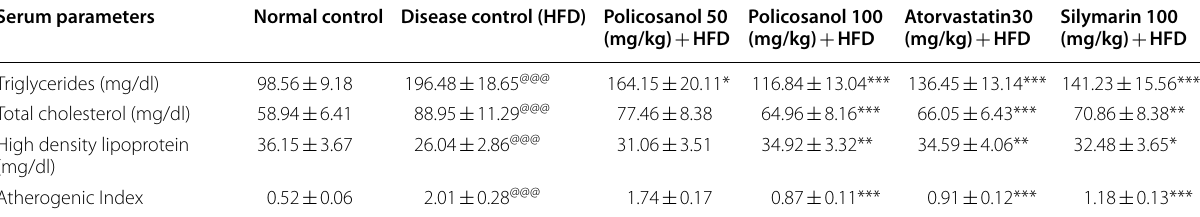
Data are represented as mean @@@ p < 0.001 compared with the normal control group * p < 0.05 compared with the HFD group